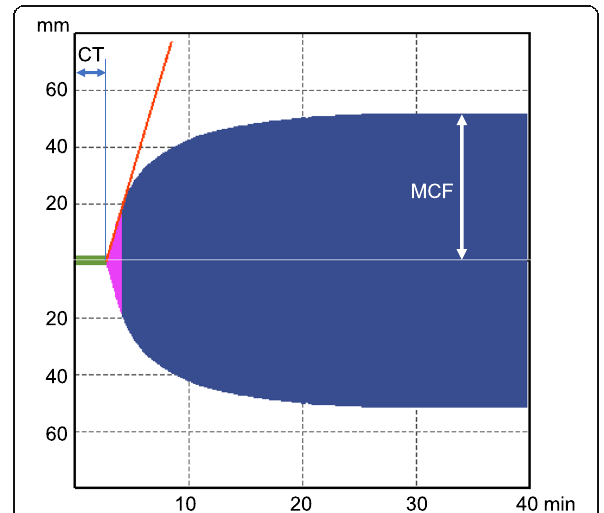
Fig. 1 A waveform of the RVV-test after anesthesia induction. Clotting time (CT) is prolonged to 167 s (normal range 48 – 77 s). CT is a time duration between initiation of the test and the time when clot firmness reaches 20 mm. CT indicates the ability of thrombin generation and is prolonged by anticoagulants such as heparin. MCF